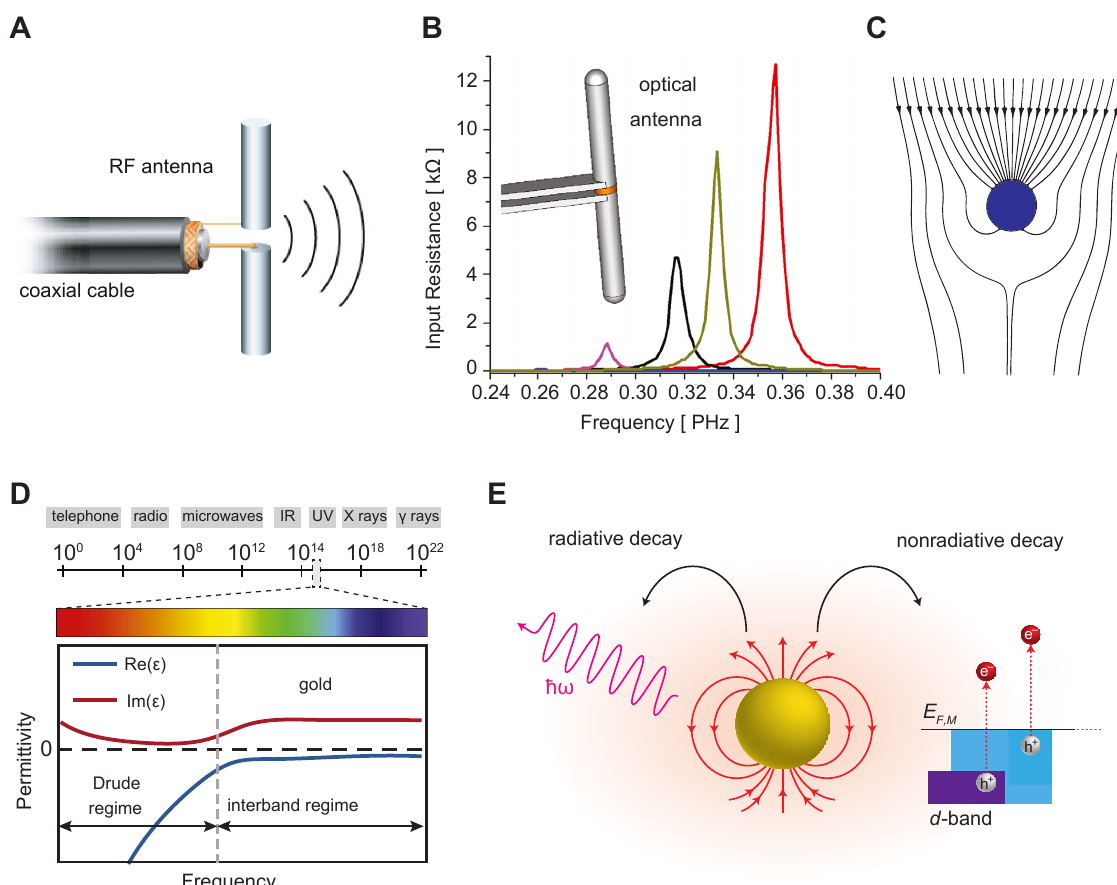
Figure 2: Subwavelength plasmonic nanoantennas (PNAs): (A) A conventional dipolar antenna operating in the radio frequency (RF) regime. Connecting the antenna to an electrical coaxial wire enables highly efficient energy conversion between local RF sources and far-field electromagneticradiation.AdaptedfromthestudybyGreffet[55];(B)PNAsoperatingintheopticalregime.AdaptedfromthestudybyAlùand Engheta [108]; (C) Electromagnetic energy is strongly focused through the optically resonant metal PNA when the localized surface plasmon resonance (LSPR) condition is met. Adapted from Brongersma et al. [88]; (D) Dielectric permittivity (experimental data by Johnson and Christy [109]) of gold at optical frequencies; (E) A schematic illustration of surface plasmon decay mechanisms: the plasmon can either decay radiatively through reemitted photons (left) or nonradiatively decay into energetic electrons (right). Adapted from the study by Clavero